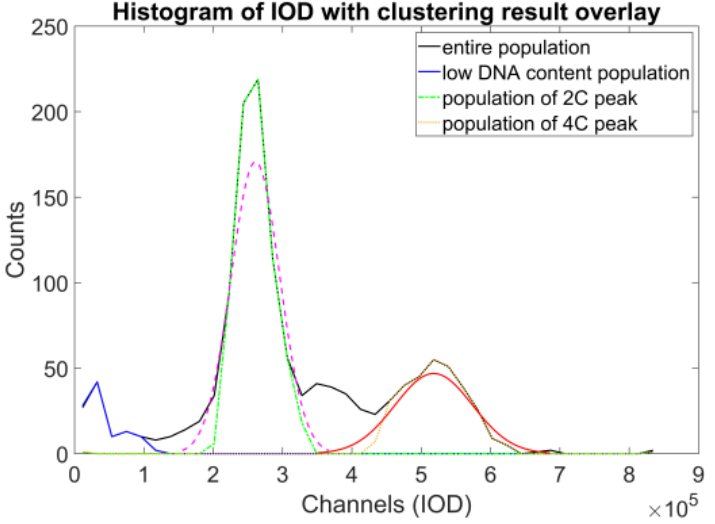
Figure 9. The DNA content distribution of sample #2, with the clusters projected back to the DNA content distribution of the sample (blue, green, orange), and normal distributions fitted to the latter two populations (magenta, red).